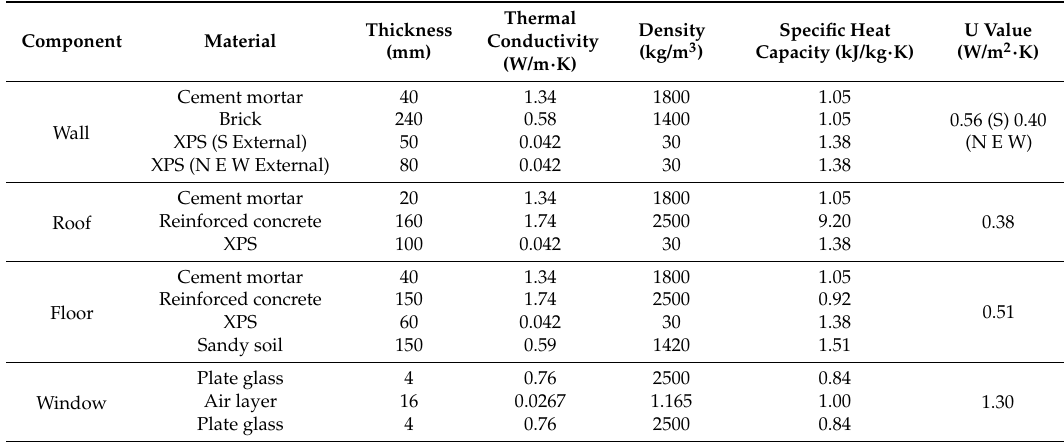
Table 1. Thermo-physical property parameters of the building envelope surfaces of the passive house.